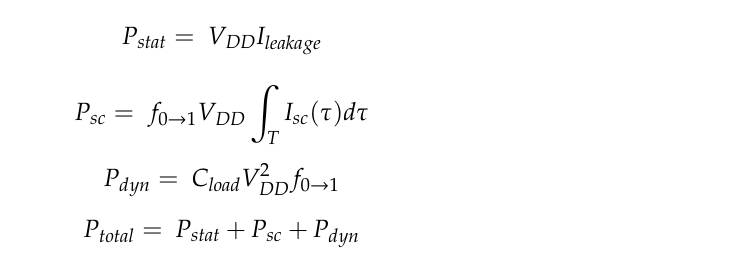
Figure 6. ( a ), ( b ) The high-to-low delay time and low-to-high delay time versus the number of TiN <200> with grain size equal to 2 × 2 nm 2 . With the increasing number of high WKs, the high-to-low delay time has become higher, and thus, the low-to-high delay time has become lower.